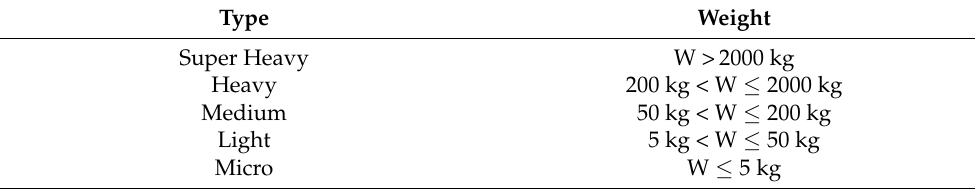
Table 1. Classification based on